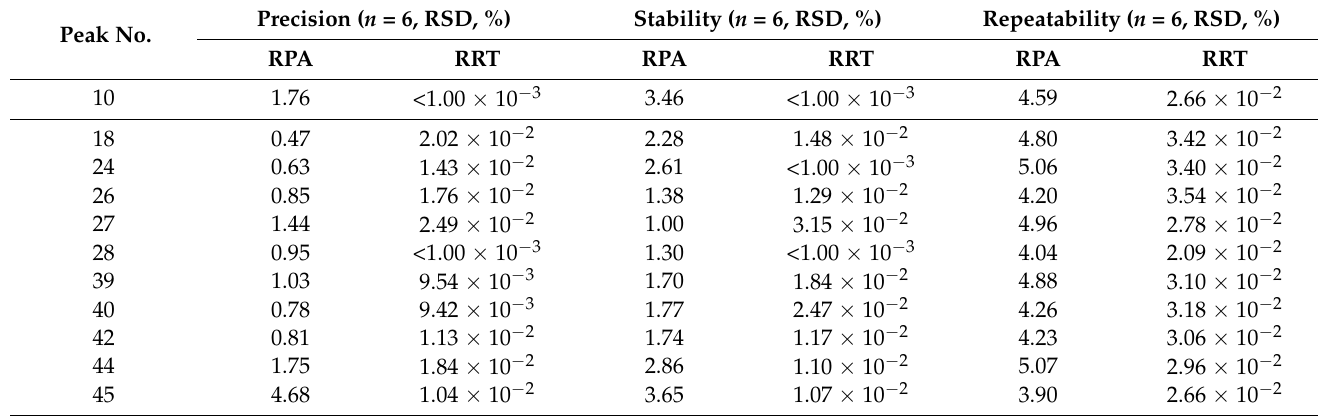
Table 2. Precisions, stabilities, and respectabilities of the GC–MS method. Peak